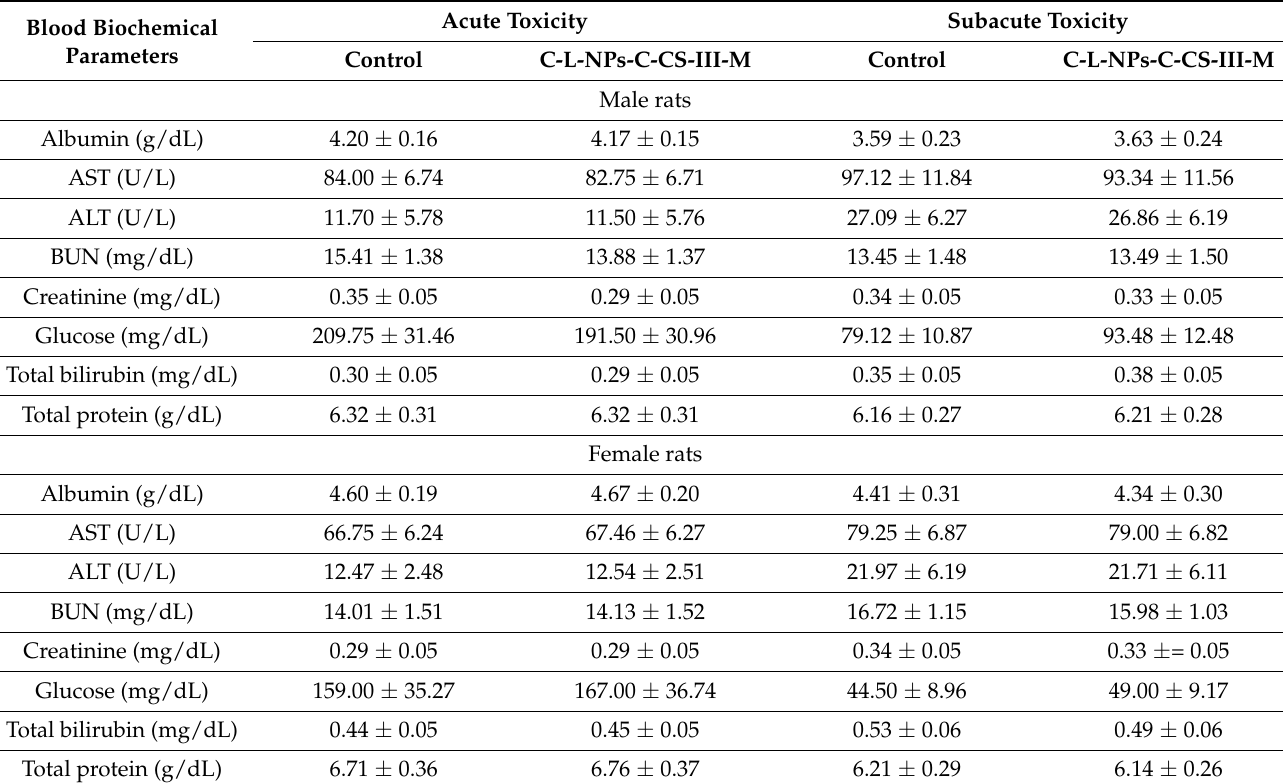
Table 13. Blood biochemical parameters of rats following oral administration of